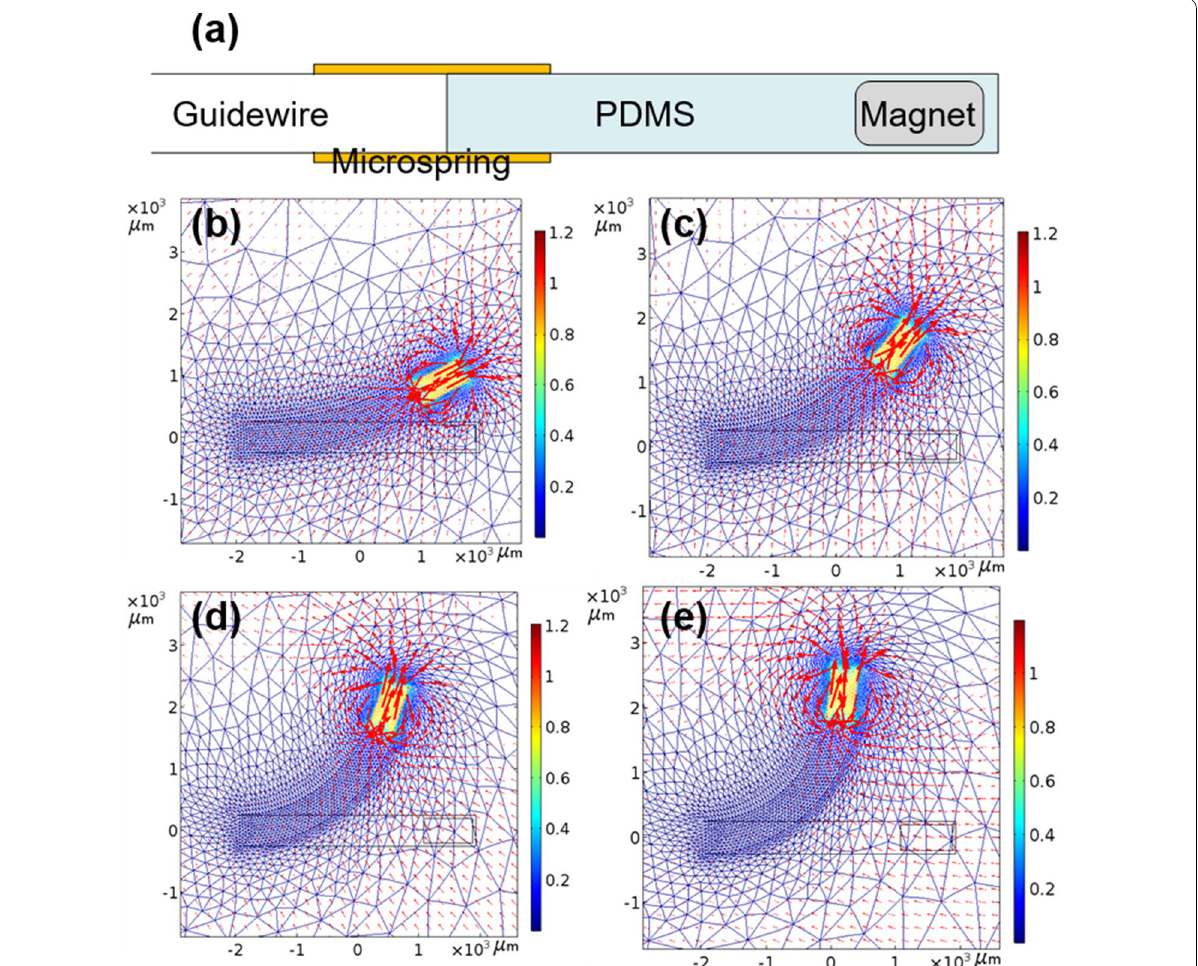
Fig. 3 Simulation of flexible microrobot deformation with a magnetic field of intensity 15 mT. a Microrobot geometry. b Magnetic field directions of 50°, c 90°, d 130°, and e